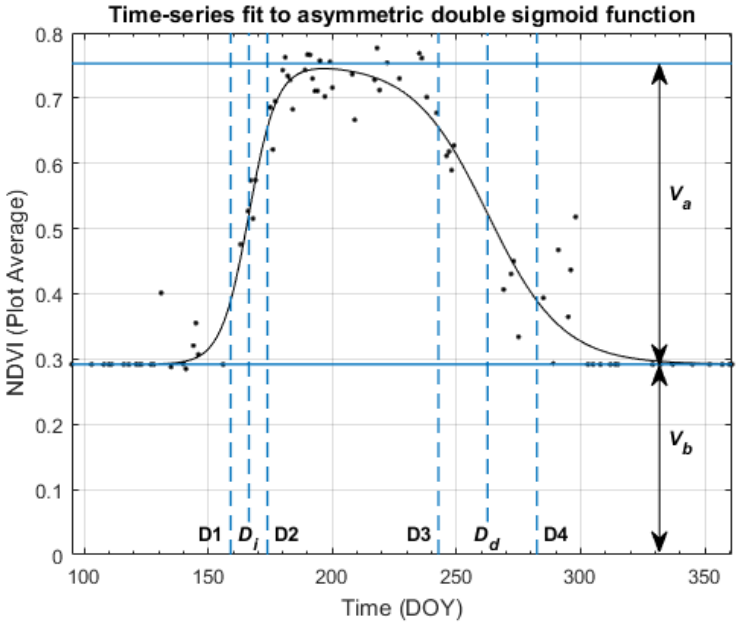
Figure 2. Asymmetric double sigmoid function fit to NDVI time-series for one of the corn subplots (Plot 74), with function parameters labeled. This figure shows original (non-resampled) time-series data, which had an average revisit interval of three